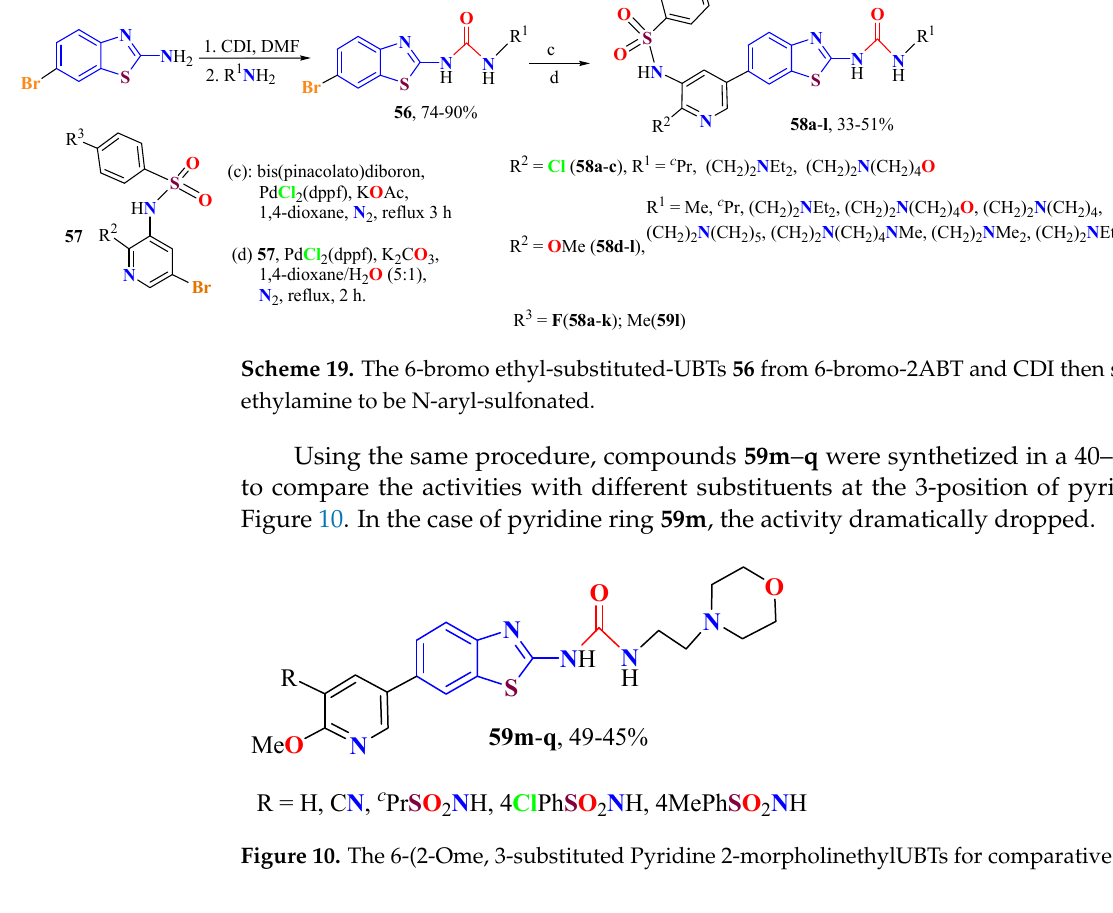
Figure 9. Tolyl UBTs 56 from the respective tolyl-isocyanate. The 6-bromo-2ABT was reacted successively with CDI and substituted ethylamine to yield 6-bromo ethyl-UBTs 56 in 74–90%, Scheme 19 [148]. Intermediates 56 were reacted successively with bis(pinacolato)diboron and intermediate 57 , catalyzed by PdCl 2 (dppf), to yield a series of 6-(2,3-disubstituted pyridine-5-yl)-ethyl-substituted-UBTs 58a – l in 33–51%. The antiproliferative activities of the synthesized compounds in vitro were evaluated against HCT116, MCF-7 U87MG, and A549 cell lines. The compounds with potent antiproliferative activity were tested for their acute oral toxicity and inhibitory activity against PI3Ks and mTORC1. The results indicate that the compounds with R 1 = 2-dialkylaminoethyl moiety 58b , 58f , 58k , and 58l retain the antiproliferative activity and inhibitory activity against PI3K and mTOR. In addition, their acute oral toxicity reduced dramatically. Moreover, compound 58f can effectively inhibit tumor growth in a mouse S180 homograft model. These findings suggest that derivatives 58f , 58k , and 58l can serve as potent PI3K inhibitors and anticancer agents with low toxicity.